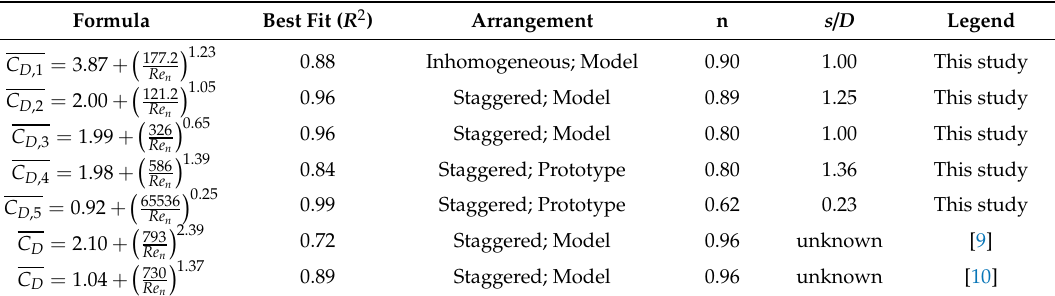
Table 3. C D and Re n relation